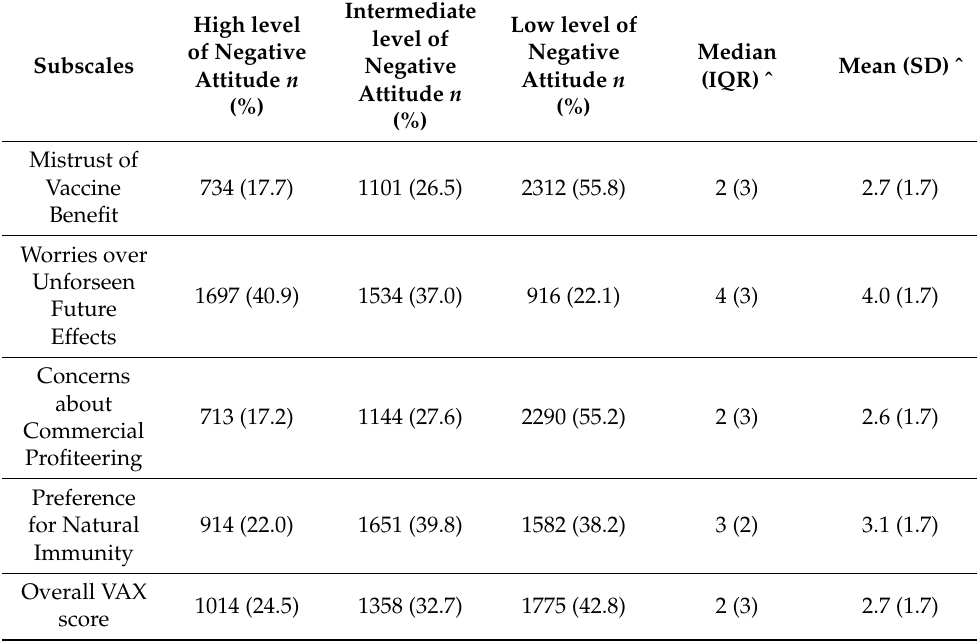
Table 5. Vaccination Attitude Examination (VAX) Subscales ( n =